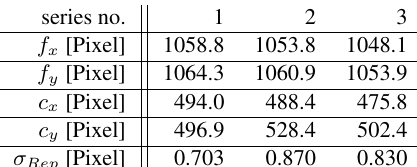
Table 1: Optical path calibration results for f L = 12 mm. The optical path calibration was performed three times for the 12 mm focal length. For each calibration series a chessboard pattern was recorded from 50 different perspectives.